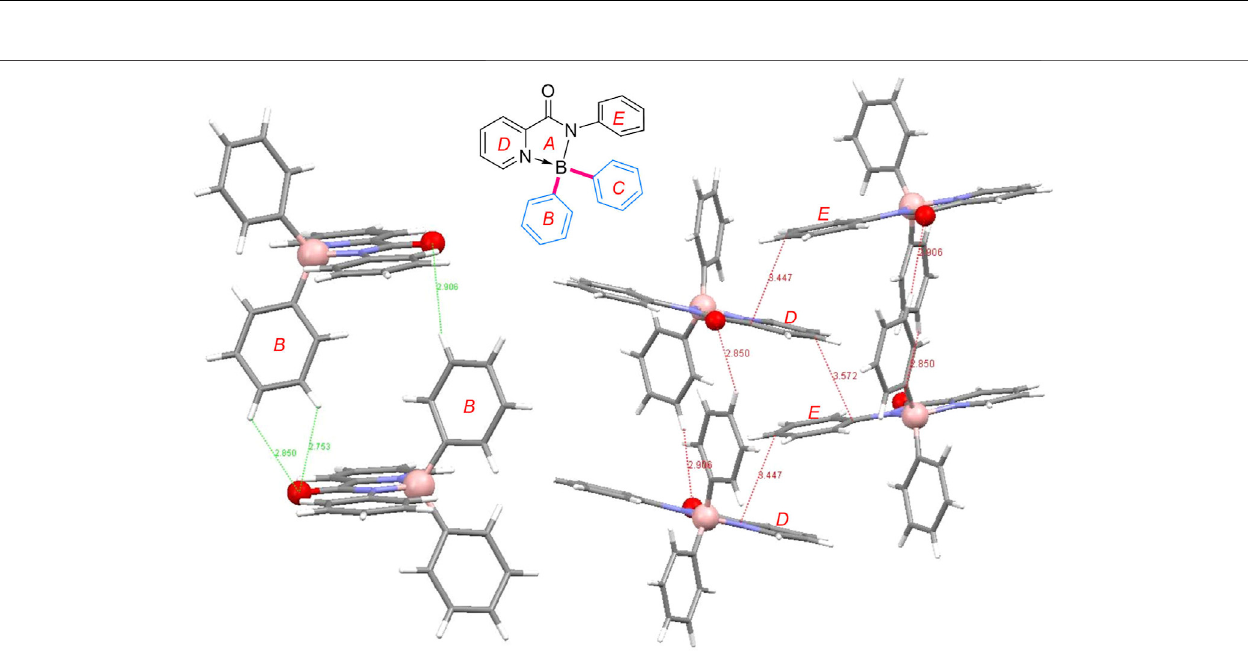
FIGURE 4 | The crystal structure of 3a